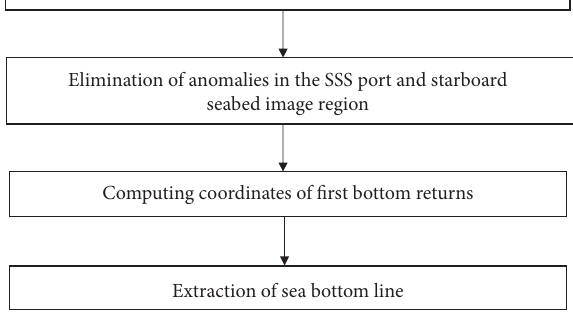
Figure 1: Automatic bottom detection procedure for